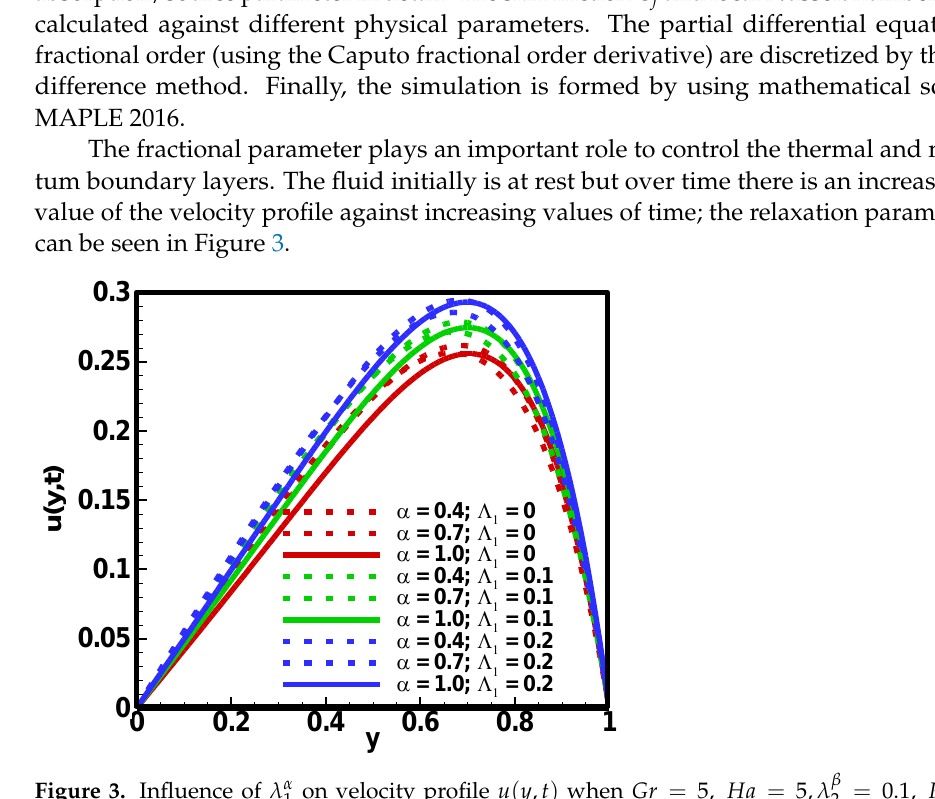
on velocity profile u ( y , t ) when Gr = 5, Ha = 5, λ β 1